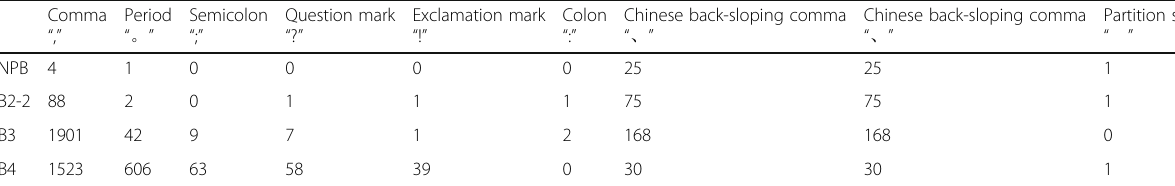
Table 2 Correlation matrix of the four break types and the eight PM types Comma Period “ , ” “ 。 ”